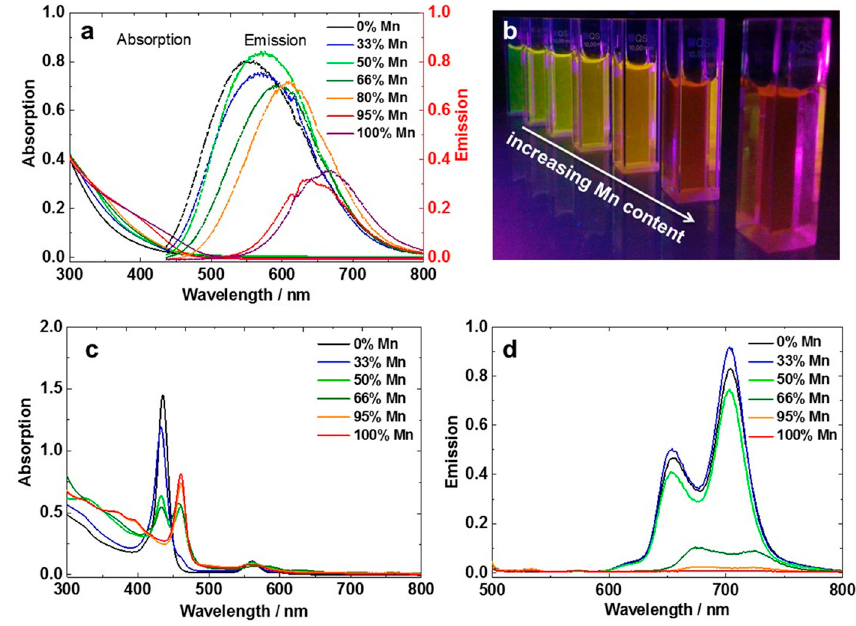
Figure 3. ( a ) Absorption and emission spectra of CdS-Zn x Mn 1-x with different Zn:Mn ratios in the shell (excited at 300 nm), ( b ) picture of fluorescing CdS-Zn x Mn 1-x nanoparticles, ( c ) absorption and ( d ) emission spectra of CdS-Zn x Mn 1-x -TAPP (excited at 447 nm).